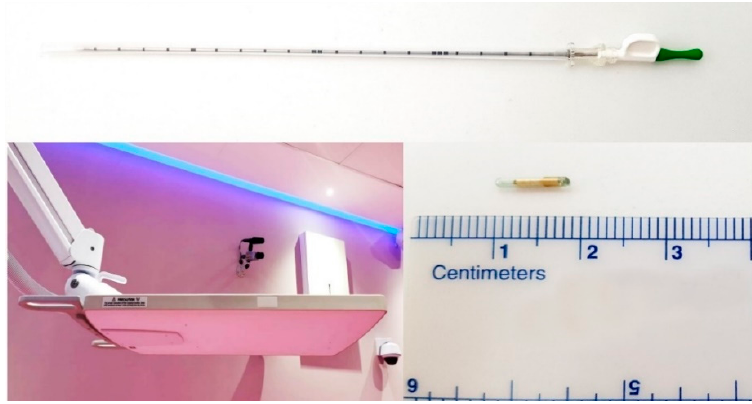
Figure 1. Implantation needle; electromagnetic array; Beacon ® transponders.